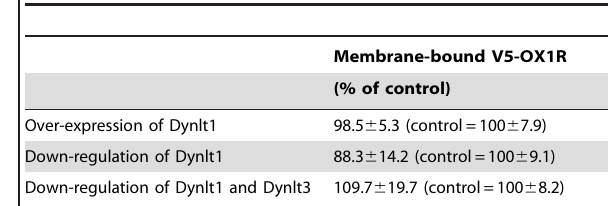
Table 1. Levels of OX1R in resting conditions at the plasma membrane in presence or absence of